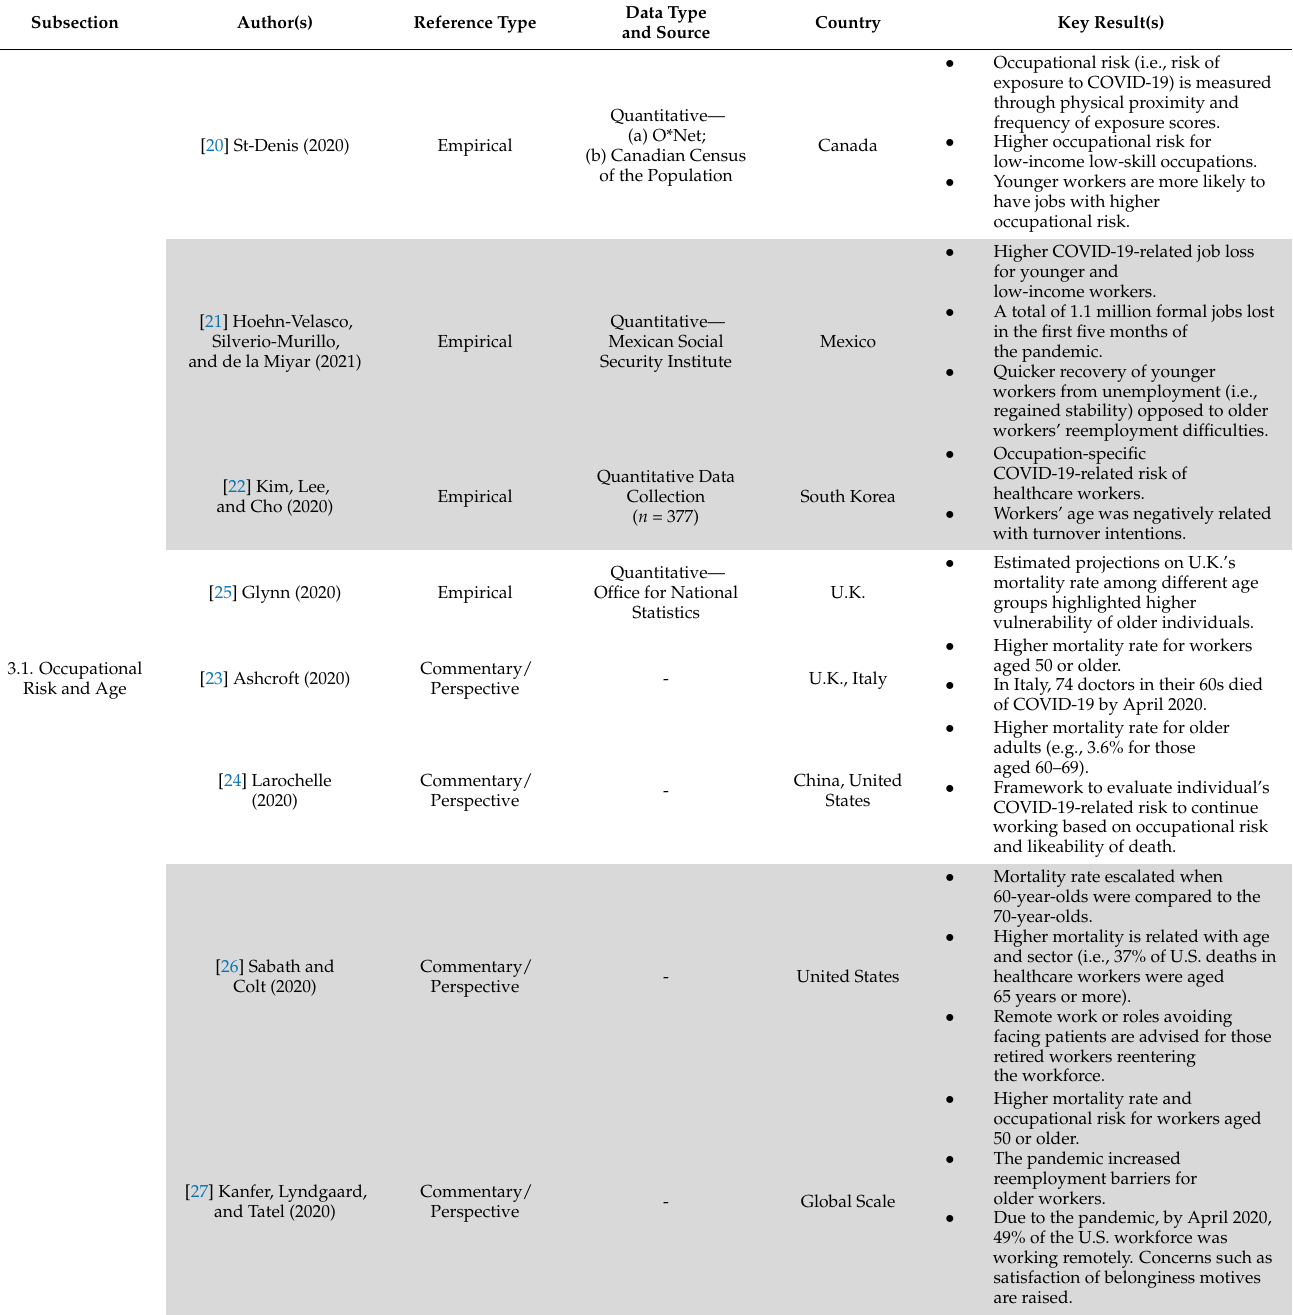
Table 1. List of papers selected for the scoping review. Papers are organized following a subsection-reference type-reference number order. Papers repeated in two or more subsections are highlighted in